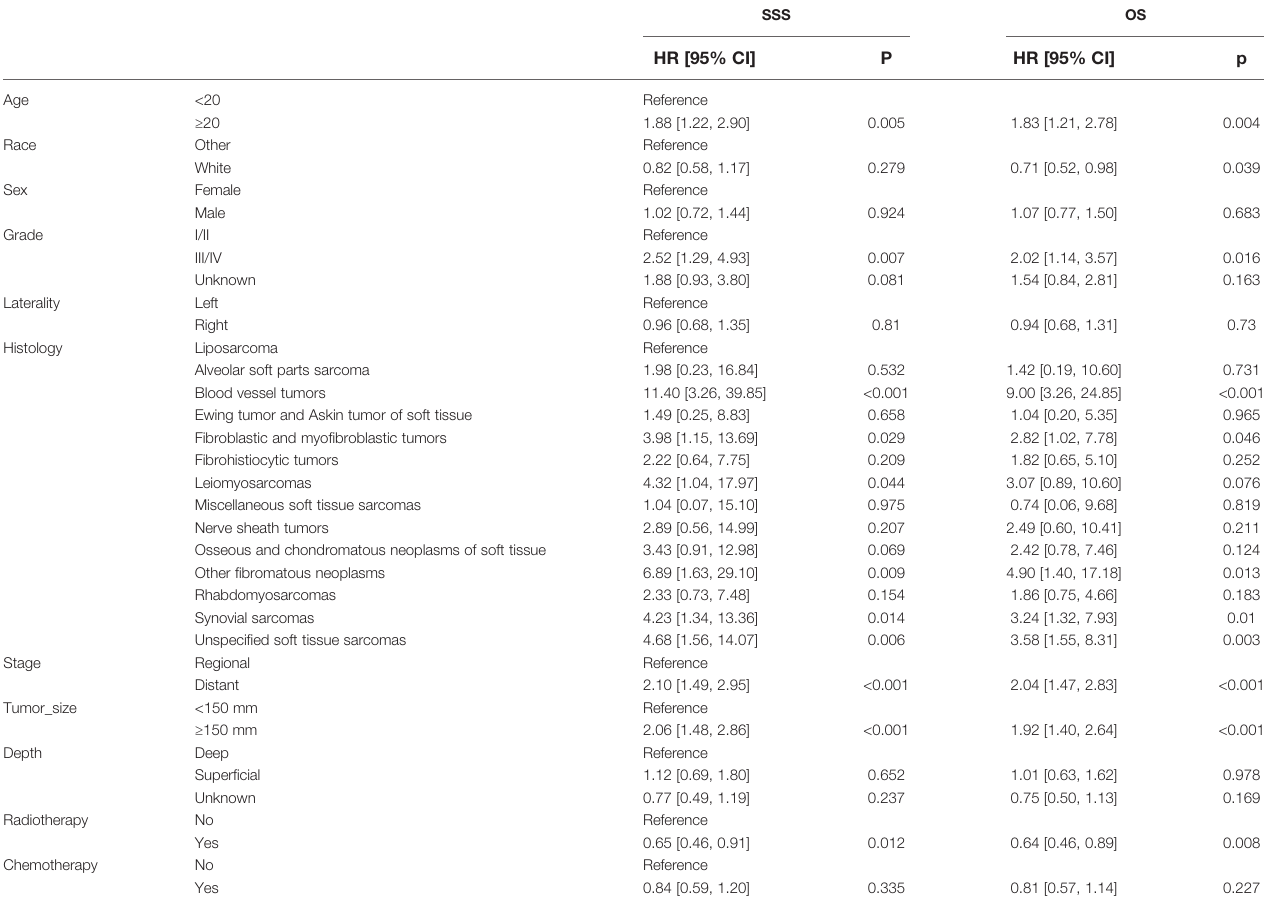
TABLE 5 | Univariable Cox regression models for sarcoma-speci fi c survival and overall survival in patients with STSE-RLNM in the IPTW-adjusted cohort. SSS OS HR [95% CI] P